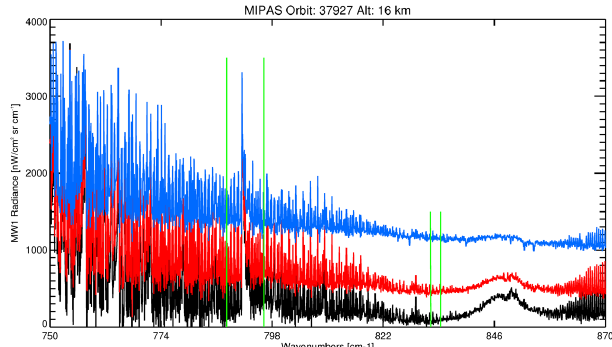
Fig. 1. MIPAS L1b spectra collected from orbit 37927 at 16km within the spectral region of 750cm − 1 to 870cm − 1 . The colours indicate cloud-free spectra (black), thin cloud spectra (red) and op- tically thick cloud spectra (blue). Thick cloud spectra become heav- ily offset due to the change in baseline radiance combined with a loss of spectral features. Such radiances changes are more apparent in the region close to 832cm − 1 relative to those observed between 788cm − 1 and 796cm − 1 (indicated by the vertical green